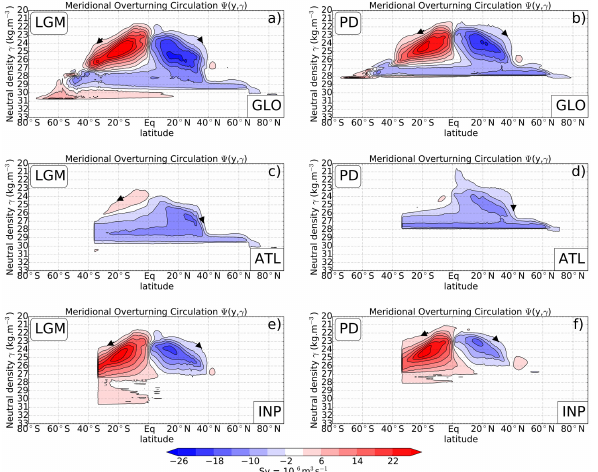
Figure 3. LGM and PD meridional overturning circulation in lat- itude–neutral density coordinates for (a, b) the Global Ocean, (c, d) the Atlantic basin and (e, f) the Indo-Pacific basin. The con- tour interval for the circulation is 4Sv. The blue cells correspond to clockwise circulations whereas the red cells are for counter- clockwise motions.